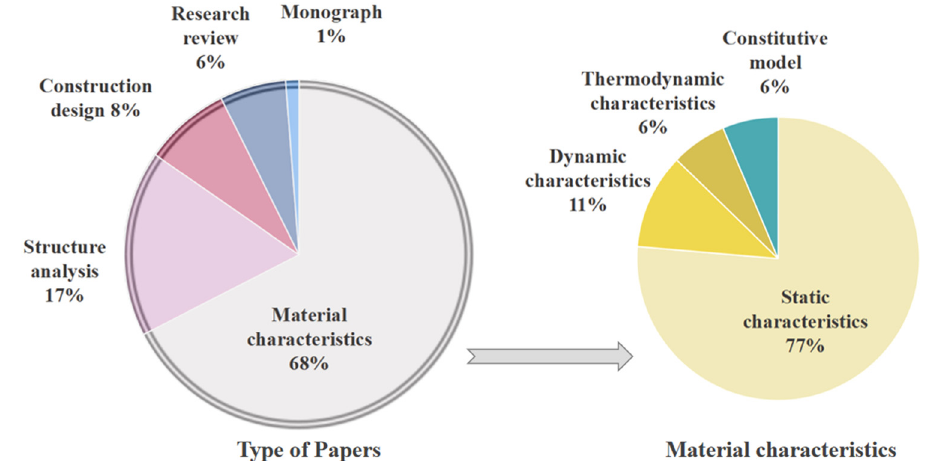
Figure 5: Types of literature